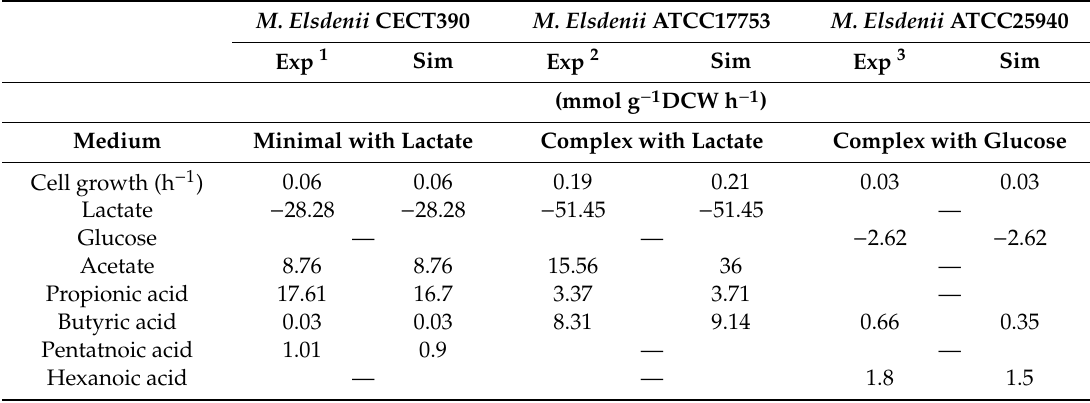
Table 1. Comparison of simulation data with experimental data in various